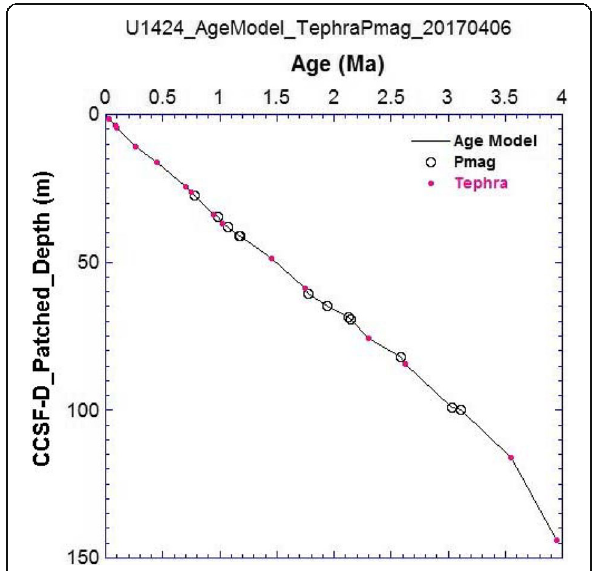
Fig. 2 A diagram showing age versus depth relationship at Site U1424 based on marker tephras and magnetostratigraphic events listed in Table 1. Depth is in CCSFD_patched meter